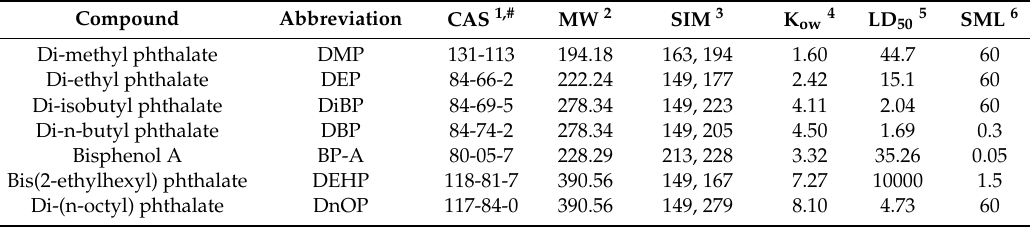
Table 1. Chemical and legislation data of the compounds investigated in this